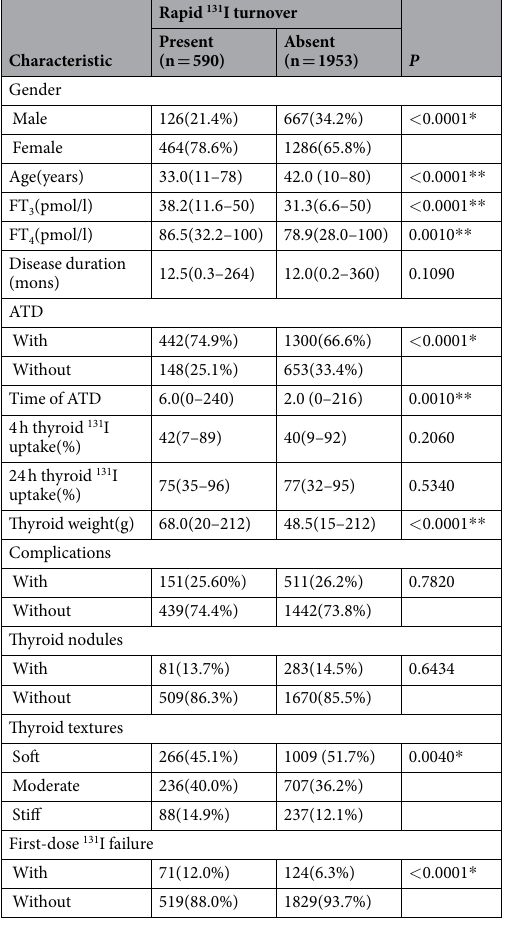
Table 2. Comparison of patient characteristics between the 2 groups. Data are presented as count (percentage) or median (range). * P value < 0.01 using chi square test. ** P value < 0.01 using Mann–Whitney U test. FT 3 = free triiodothyronine, FT 4 = free thyroxine, SD = standard deviation, ATD = antithyroid